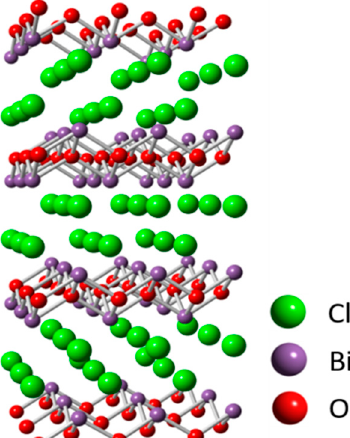
Figure 9. Schematic 2D layer structure of BiOCl (ICSD no. 74502).